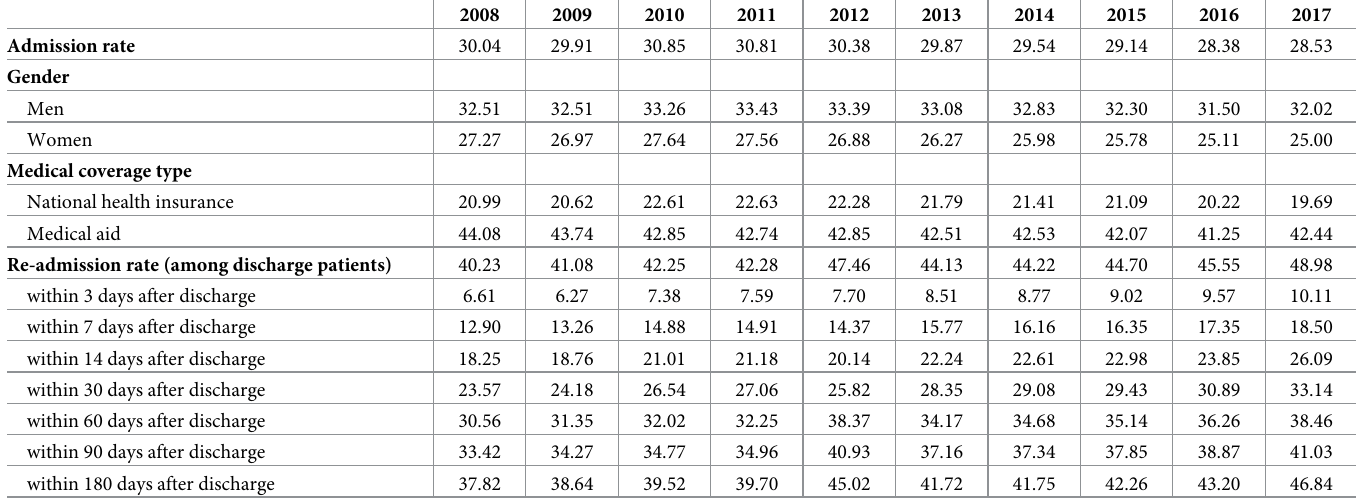
Table 3. Admission and re-admission rate of schizophrenia, schizotypal and delusional disorders, 2008–2017.